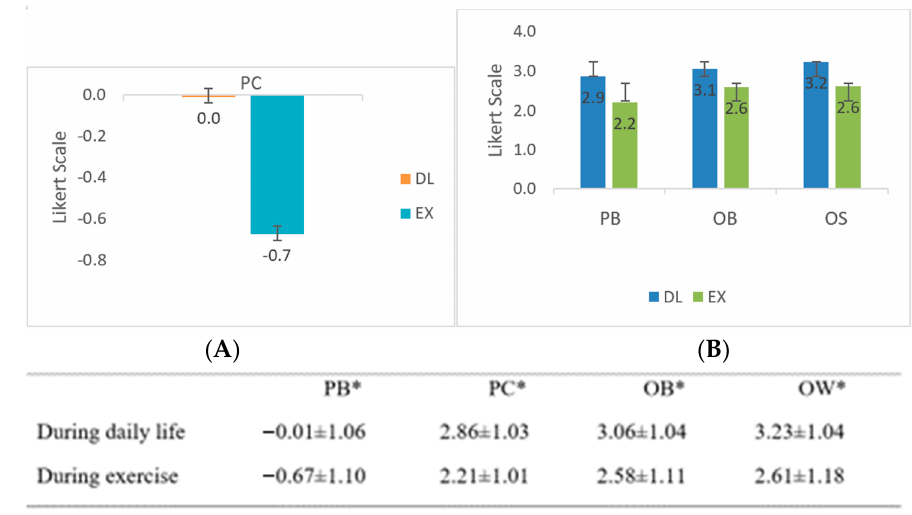
Figure 2. The means and SD of ( A ) PC, ( B ) PB, and PAQ (OB and OS).